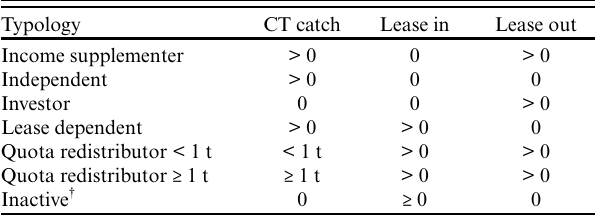
Table 1 . Account holder typology